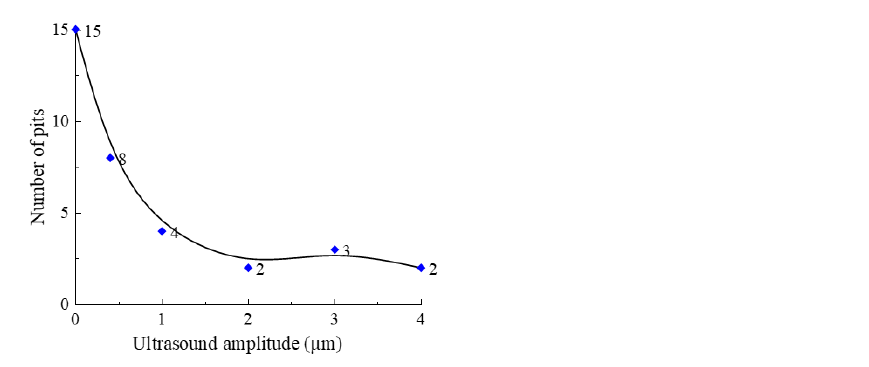
Figure 5. Relationship between ultrasonic amplitude and number of pits.